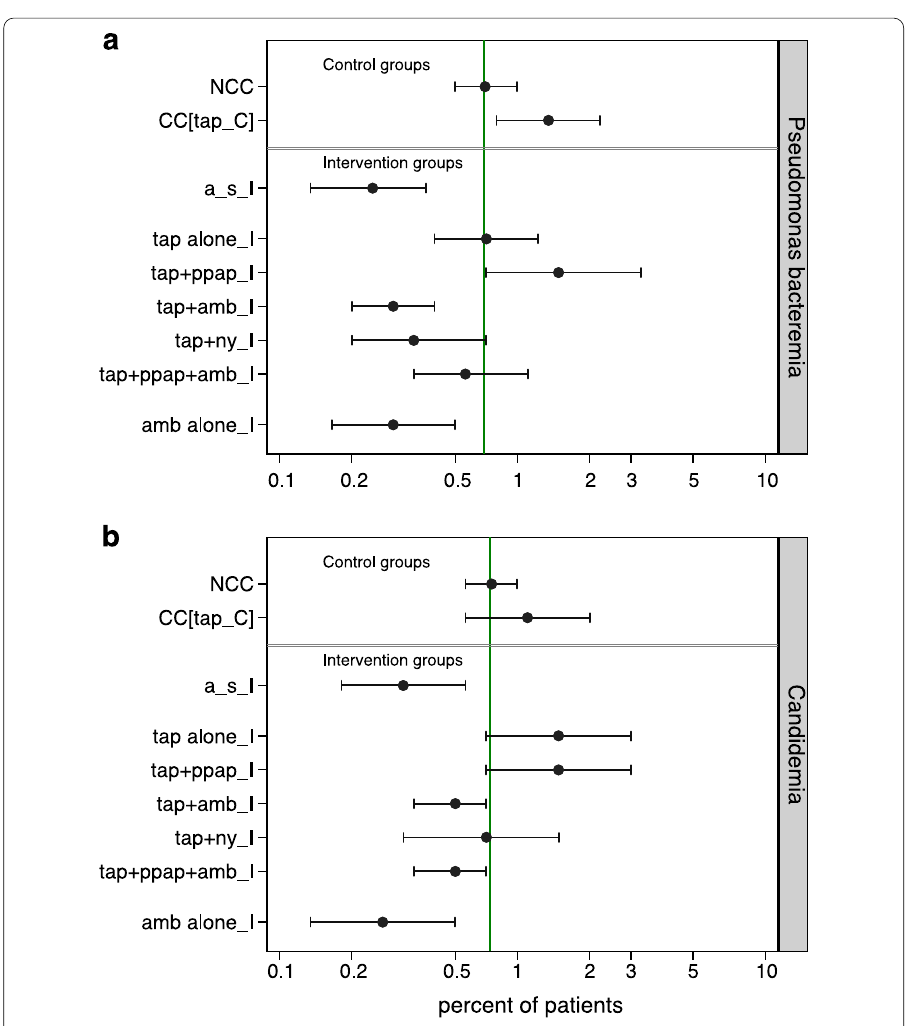
LOS > 7 days without selection for CRF. The projections are for control (top) or intervention (bottom panel) groups receiving prophylaxis with various singleton or combination interventions. In each plot, the benchmark proportion (solid vertical line) is the mean prediction derived for an equivalent NCC group without exposures. NCC non-concurrent control, CC concurrent control, non-D